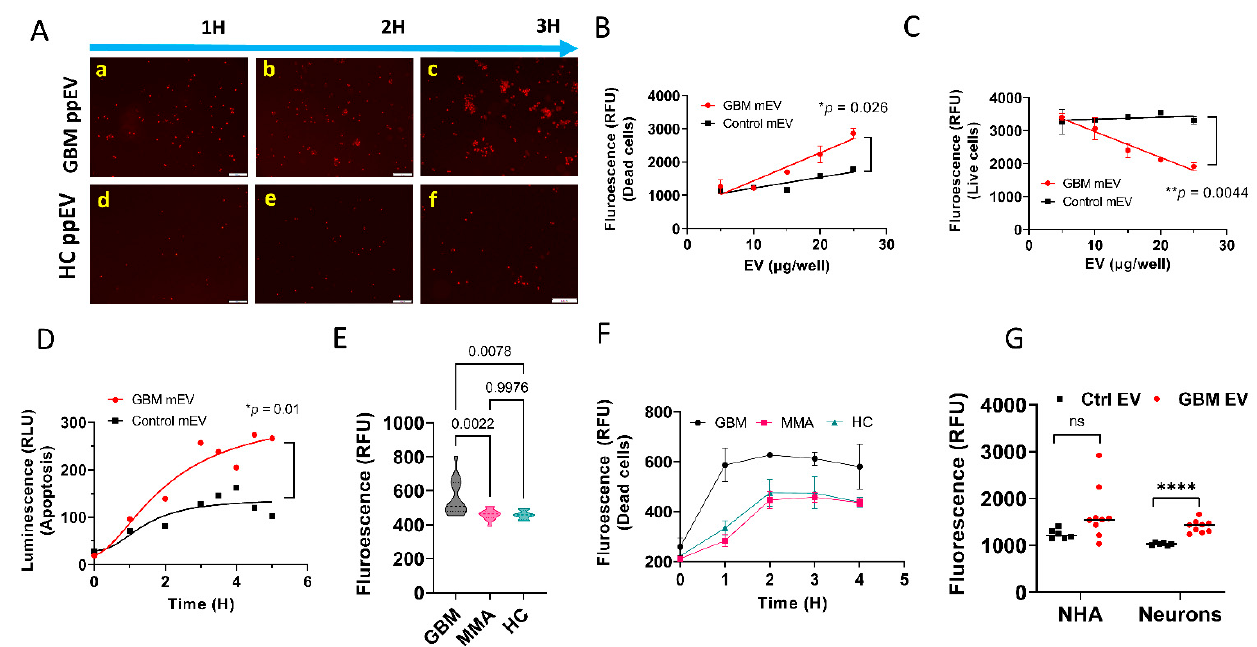
Figure 2. GBM extracellular vesicles derived from both plasma and tumor cell lines produced cytotoxicity in neurons and brain tissues. ( A ). Fluorescent microscopy images showing that GBM plasma EVs produced cell death in neuroblastoma cells in a time-dependent manner. SH-SY5Y cells (30–40% confluency) were incubated with GBM plasma and control EVs (50 µg/mL), 5% Normal Human Serum as a complement source, and propidium iodide. GBM pooled plasma EVs (GMB ppEV) produced large numbers of dead cells (red fluorescence) in a time-dependent manner ( a – c ) compared with control plasma EV (HC ppEV) treated cells ( d – f ). Scale bar = 100 nm. ( B , C ). Neuronal death caused by GBM EVs is dose-dependent. ( B ). A significantly higher number of dead cells were observed in GBM tumor cell line medium EVs (mEV) treated cells compared with controls in a dose-dependent manner (* p = 0.026). ( C ). Significantly lower number of live cells was detected in GBM mEV-treated cells compared with controls in a dose-dependent manner (** p = 0.0044). ( D ). GBM cell line EVs produced apoptosis in mouse brain tissues. P1 mouse brain slices (2 mm diameter) were incubated with GBM mEV and apoptosis was measured by luminescence. GBM mEVs produced significantly higher levels of apoptosis compared to controls (* p = 0.01). ( E , F ). GBM plasma EVs induced higher levels of cytotoxicity in SH-SY5Y cells. Plasma EVs were purified by ExoQuick and incubated with neuroblastoma cells. Cell death was measured by propidium iodide. ( E ). GBM plasma EVs produced significantly high levels of cytotoxicity compared to MMA ( p = 0.002) and HC EVs ( p = 0.008). n = 14 for GBM and MMA, n = 8 for HC. ( F ). Time-dependent cytotoxicity by GBM EVs. ( G ). GBM medium EVs did not induce significant cytotoxicity to normal human astrocytes (NHA) as compared to Control medium EVs. GBM and Control mEVs, used to treat the neurons and astrocytes, were purified by ultracentrifugation. Cell death was measured by propidium iodide. The results showed no significant cytotoxicity in astrocytes treated with GBM mEV versus Control mEV treated cells (n = 9 for GBM mEV, n = 7 for Control mEV, ns, not significant, **** p >